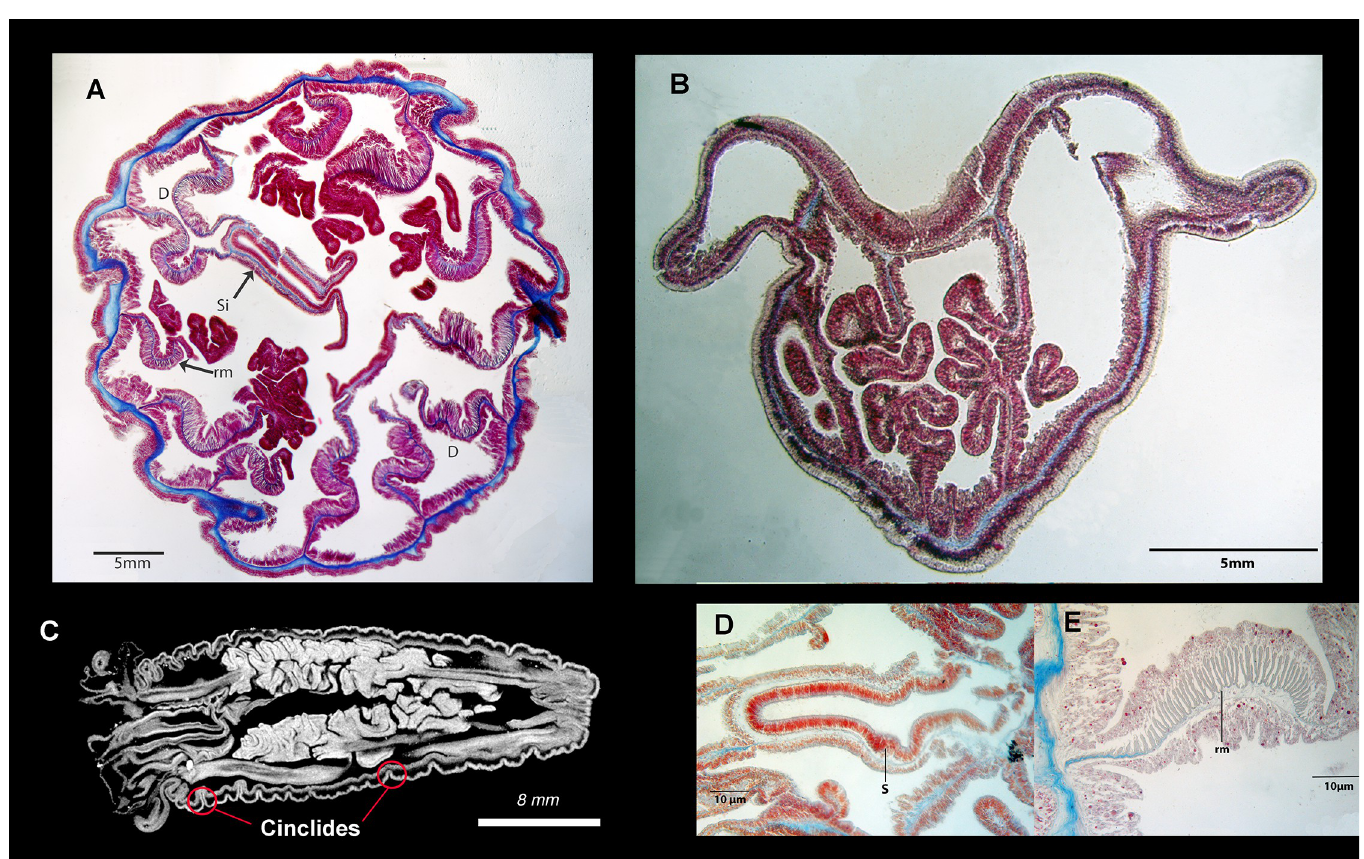
Fig 5. Internal anatomy of Peachia chilensis . (A) Histological cross section through the column showing the cycles of the mesenteries and the siphonoglyph not completely separated from the actinopharynx. Mesentery pairs numbered. (B) Histological longitudinal section through the entire animal, highlighting the absence of a marginal sphincter. (C) Longitudinal micro-CT scan with the cinclides visible. (D) Histological cross section highlighting the siphonoglyph. (E) Cross section highlighting the detail of a retractor muscle. D = directives, si = siphonoglyph, rm = retractor muscle.